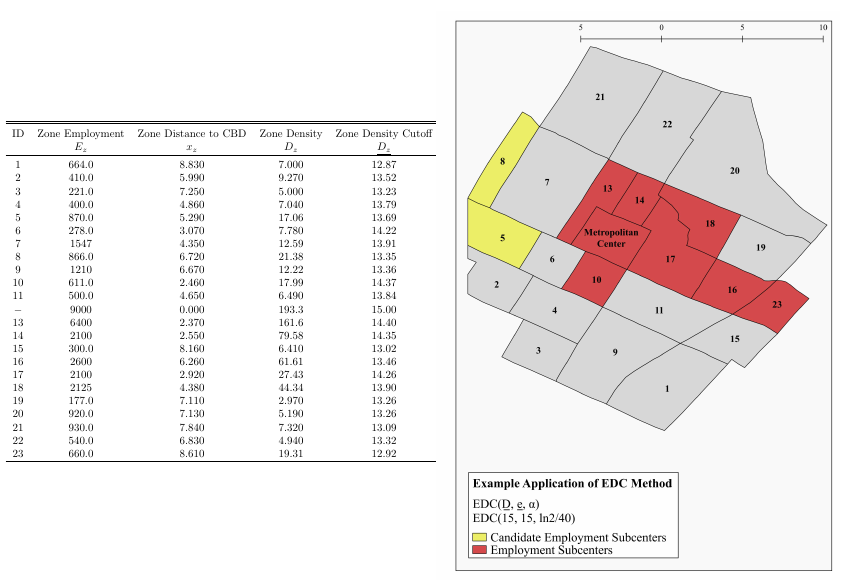
Figure 2. Hypothetical metropolitan area subcenters identified by EDC(15, 15, ln 2 / 40 ).